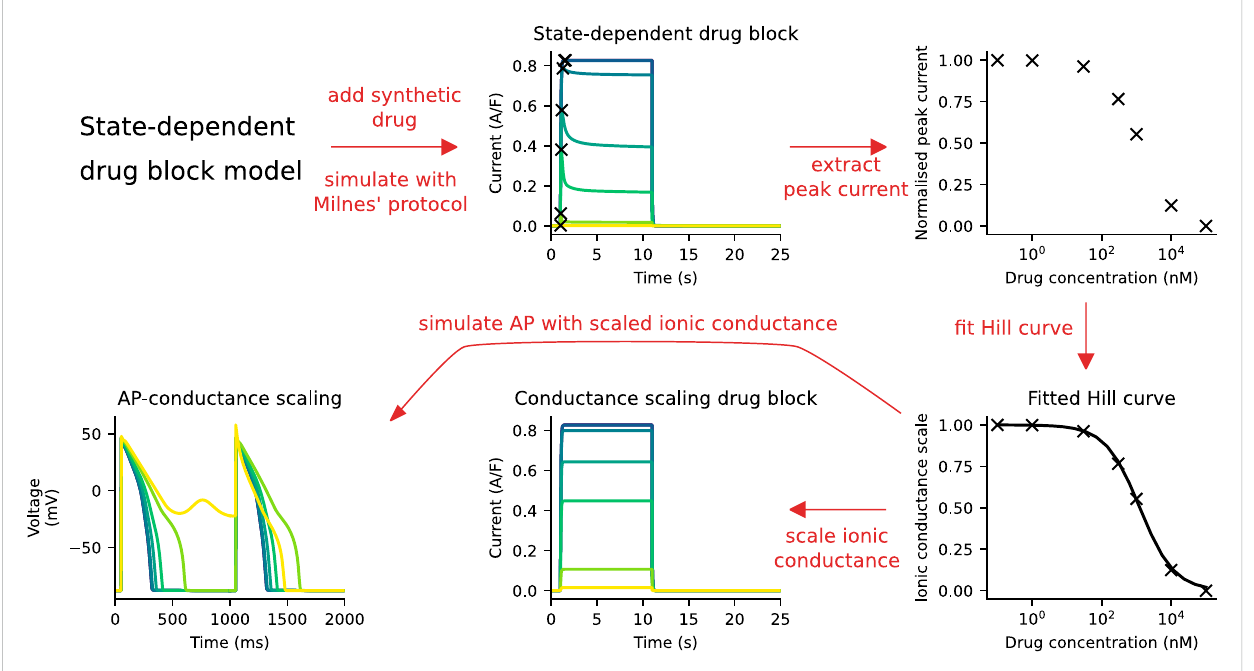
FIGURE 2 Aschematicoftheprocess of fi ttingtheCSmodelto theSDmodel. First,simulationsarerun withtheSDmodelandMilnes ’ protocolatvarious drug concentrations.ThepeakofthehERGcurrentsareextracted andnormalised, andaHillcurveis fi ttedtothenormaliseddatapoints. ThisHillcurveisthen used to scale the ionic conductance of the CS model. Finally, the simulated APs of both models are